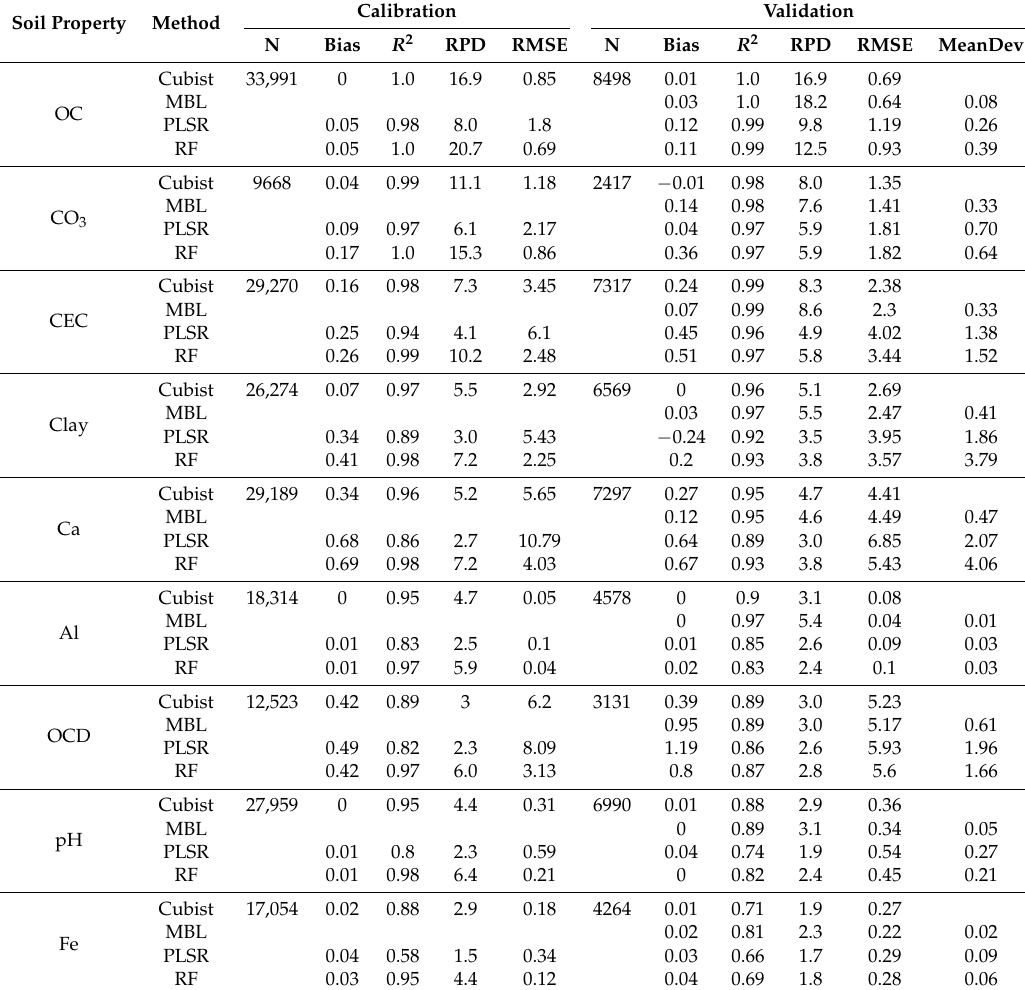
Ratio of performance to deviation (RPD) is calculated as the ratio of standard deviation of the observed soil property to the root-mean-square error in the prediction, and mean deviation (MeanDev) is the average of the uncertainty estimates for all samples in the validation sets. All predictions were back-transformed prior to calculating goodness-of-fit